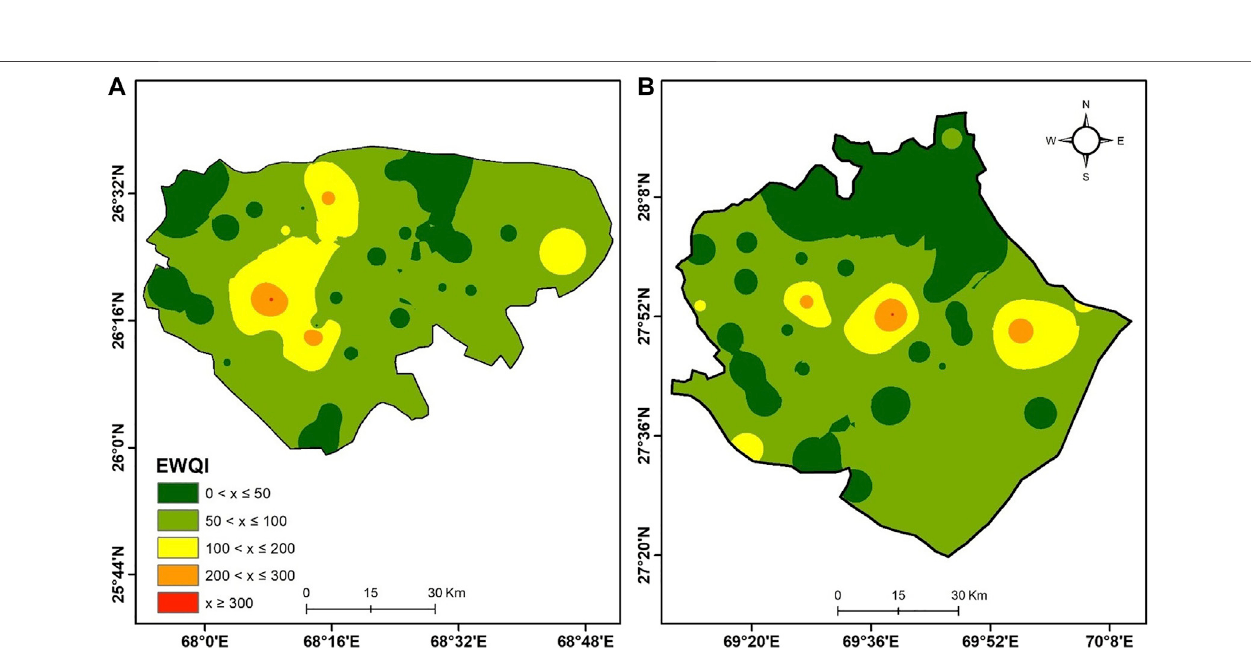
Frontiers in Environmental Science |